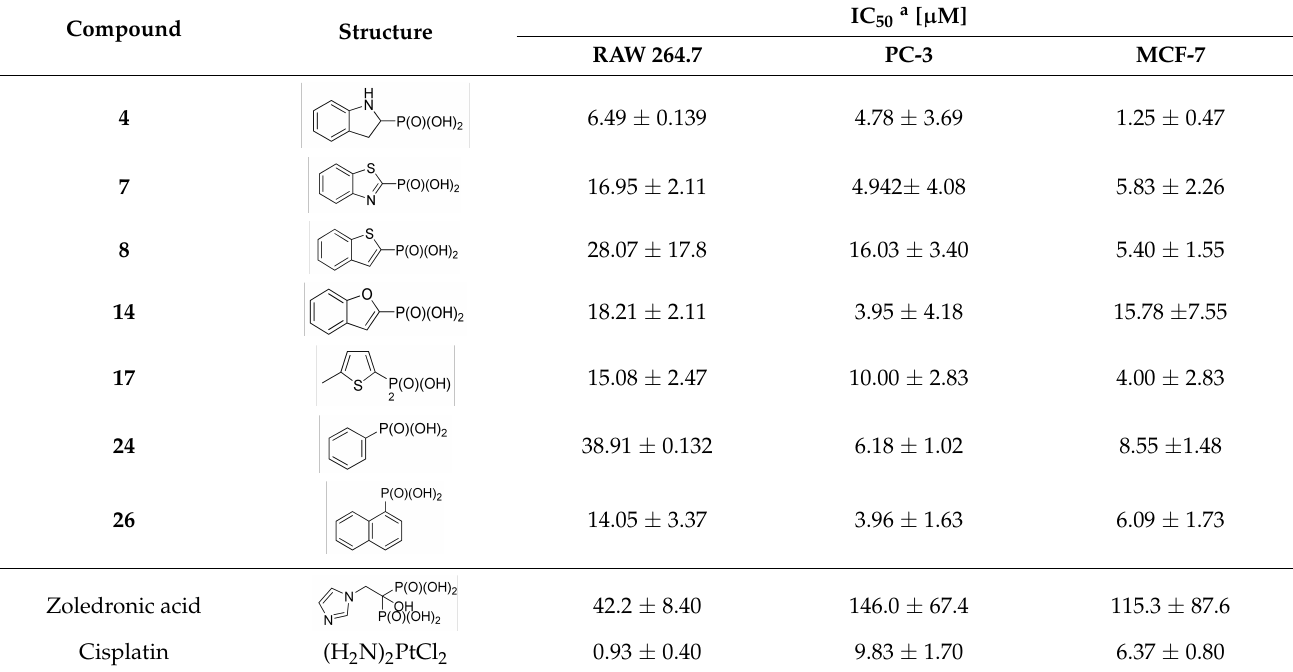
Table 2. Structures and in vitro antiproliferative activities of the phosphonic acids against RAW 264.7 mouse macrophages, PC-3 human prostate cancer cells, and MCF-7 human breast cancer